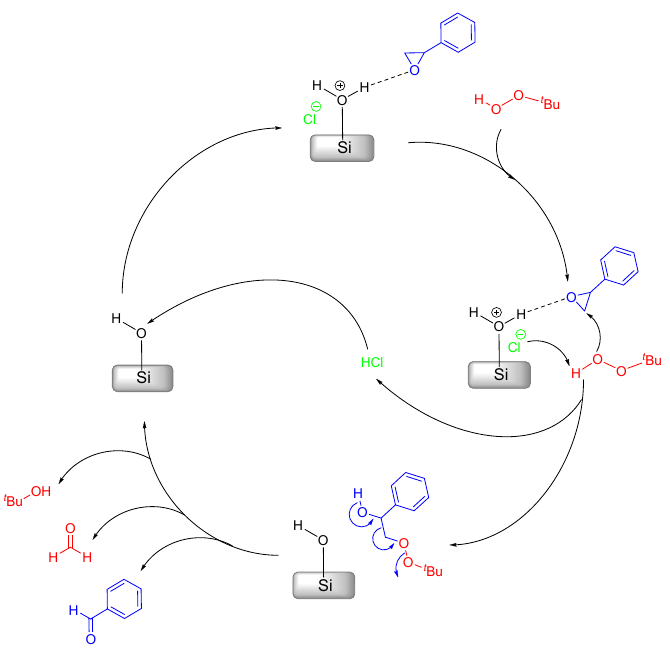
Scheme 2. Mechanistic proposal for the catalytic benzaldehyde formation from styrene oxide cat- alyzed by acid sites at the surface of